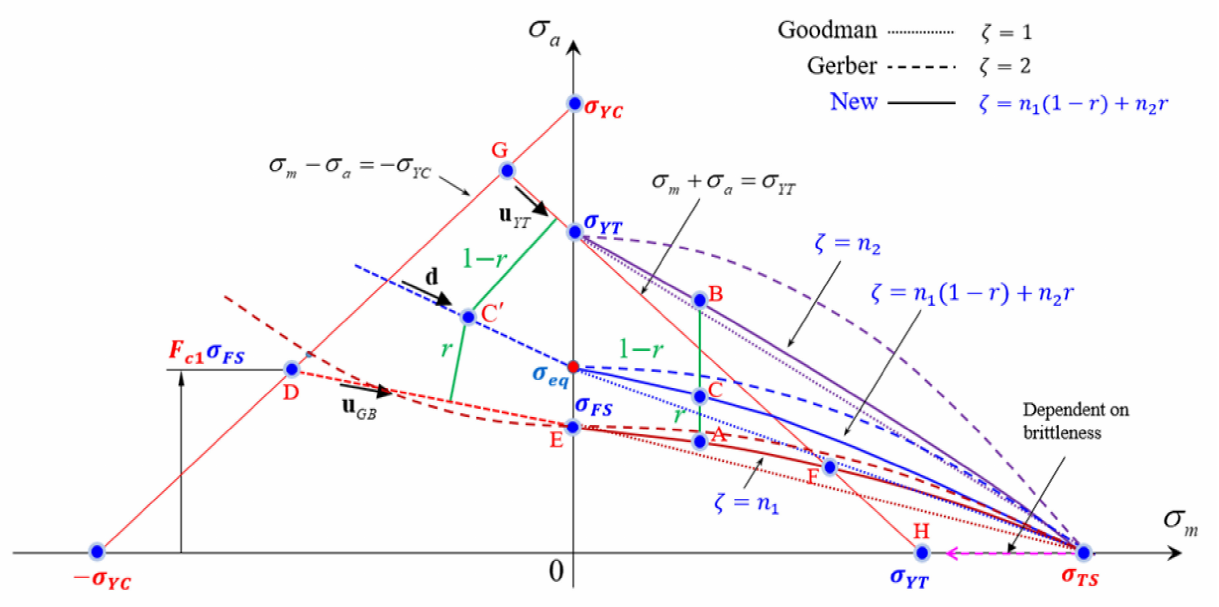
Figure 11. A generalized fatigue limit